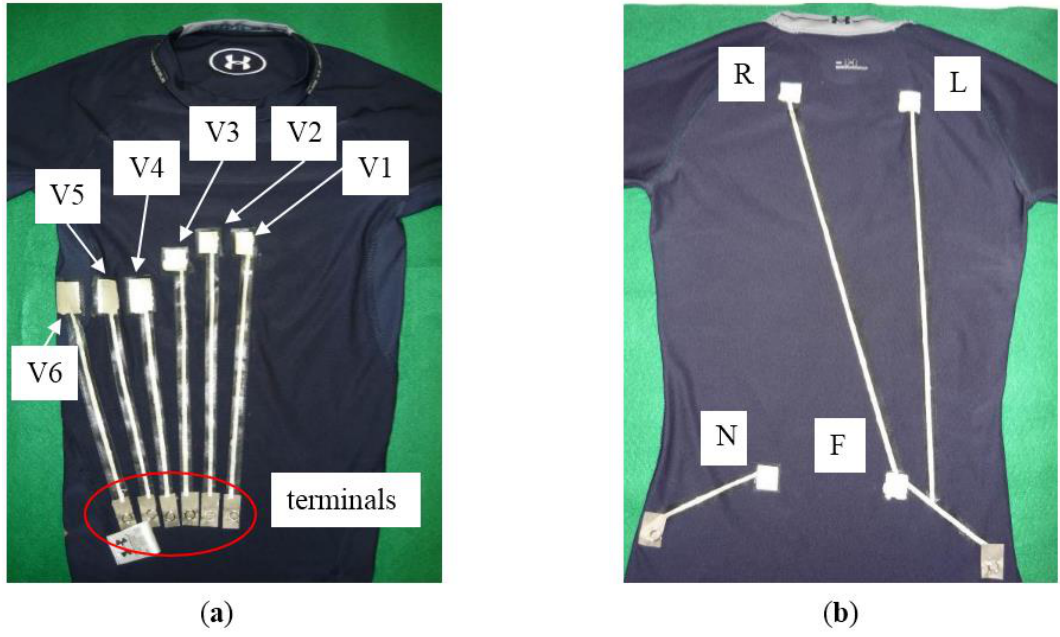
Figure 3. Manufactured smart shirt. The smart shirt is inside out in the photographs to show electrodes and wires: ( a ) front view; ( b ) back view.